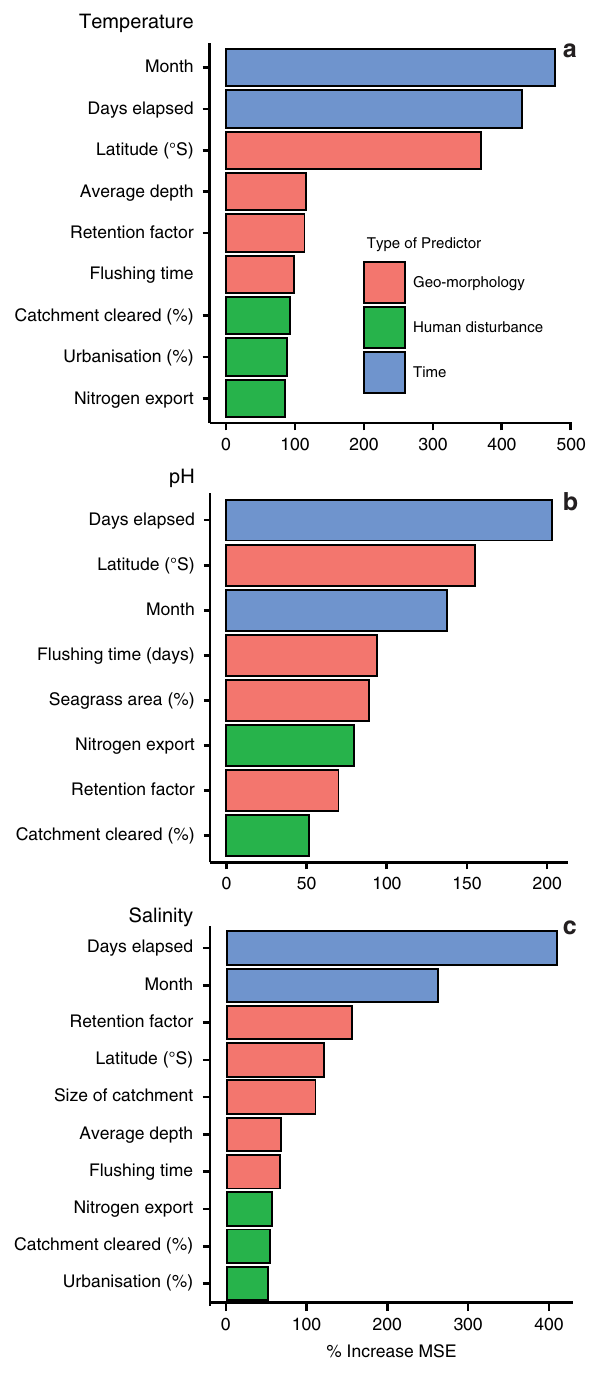
Fig. 2 Relative importance of variables in predicting estuary temperature, pH and salinity. Variable importance plots (% MSE as an indicator of importance 73,74 ) for a temperature, b pH and c salinity generated from random forest models. Predictor variable categories are colour coded.